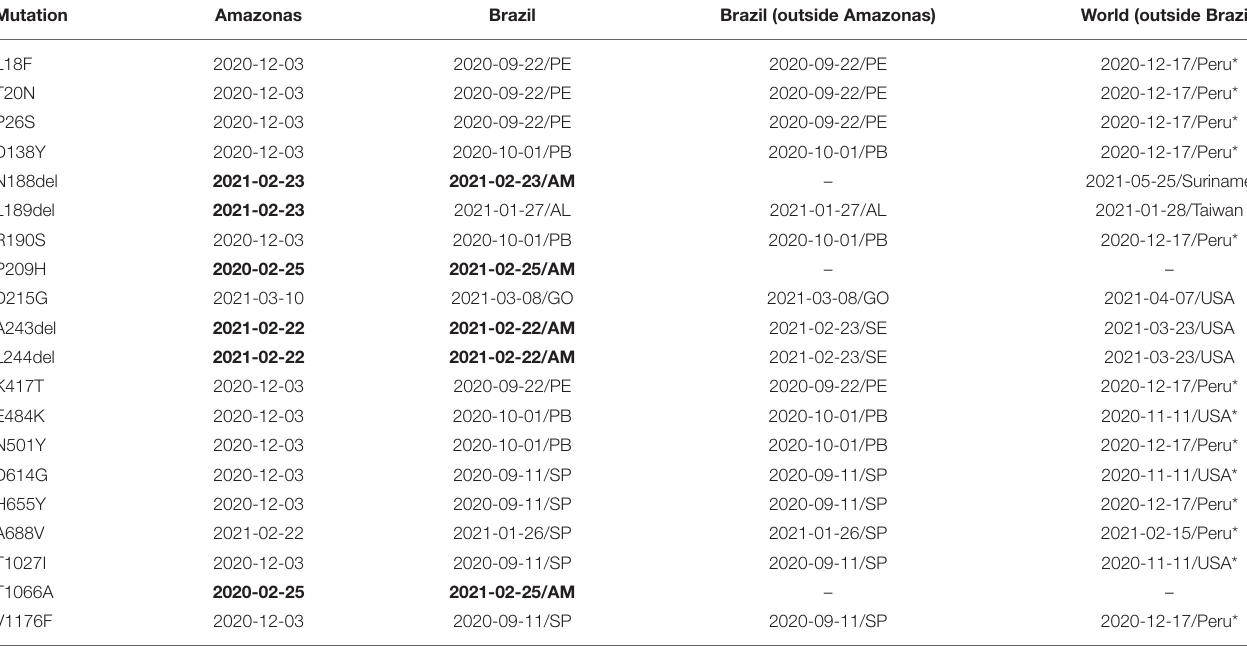
TABLE 3 | First occurrence (by collection date) registered on GISAID for spike mutations identified in the sequenced genomes from this study.